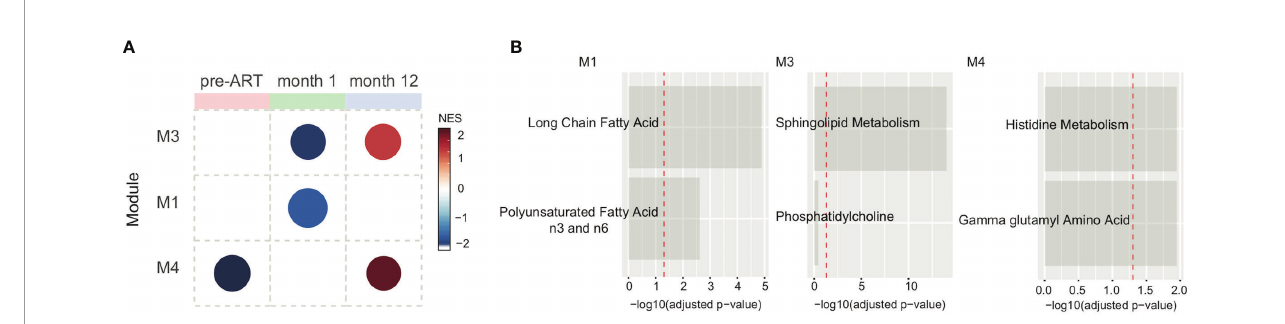
FIGURE 3 | Metabolic pathway module analysis. Co-expressed pathway modules are obtained by using metabolite fold-difference values comparing IRIS with non- IRIS groups analyzed with the CEMiTool R package. (A) Module activity for each time point is shown. Color scale re fl ects the network enrichment score (NES) of each module. Red color indicates a high degree of representation and blue represents low degree of representation. (B) Metabolic pathways that de fi ne the three identi fi ed modules are depicted. Bar graphs show the – log 10 adjusted p -value of fold difference from the metabolomics dataset. The vertical dashed red line indicates an adjusted p -value